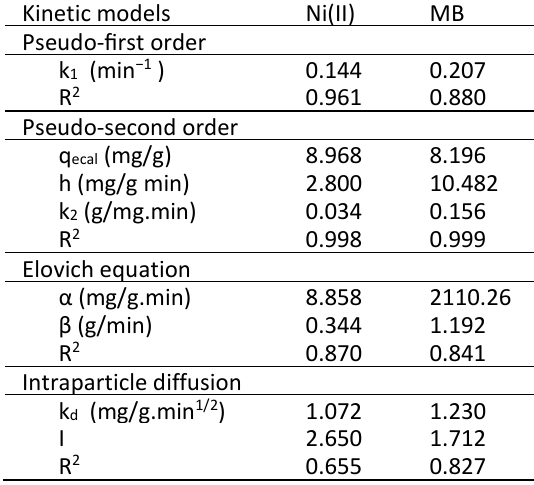
Comparison of the kinetic model equations on the adsorption of N(II)) ions and MB(II) from solution unto natural clay Kinetic